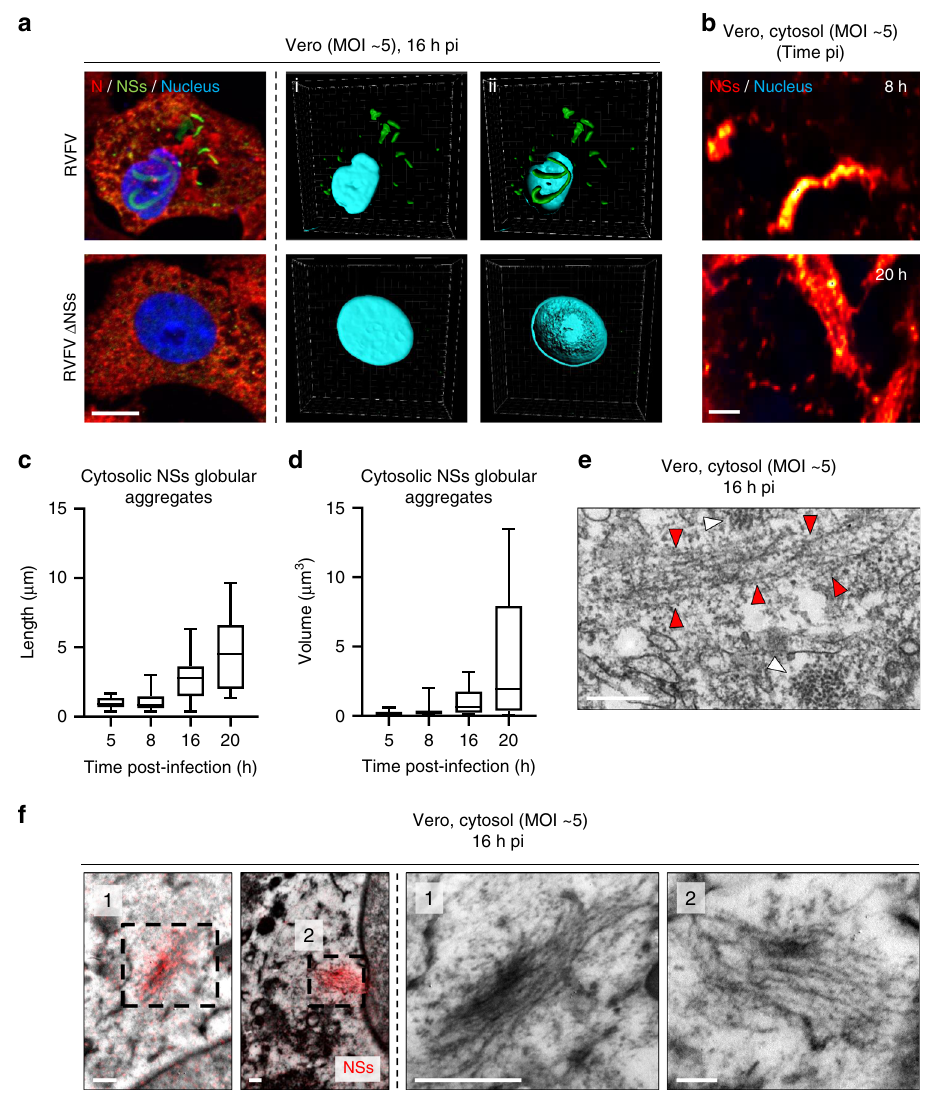
Fig. 6 NSs assembles into short cytosolic amyloid-looking fi brillary aggregates. a Vero cells were infected for 16 h with RVFV or RVFV Δ NSs, both at a MOI of 5. Infected cells were imaged by confocal microscopy after labeling of nuclei with Hoechst (blue) and immuno fl uorescence staining of intracellular RVFV proteins N (red) and NSs (green). The left panel shows Z-stack projections whereas the three others are 3D-reconstructions obtained with IMARIS software and displaying (i) cytosolic NSs and (ii) nuclear NSs. Results are representative of three independent experiments. Scale bar, 10 µ m. b Vero cells were infected with RVFV for 8 and 20 h and subjected to immuno fl uorescence staining against NSs. Cytosolic NSs aggregates (red/yellow) and nuclei (blue) were imaged by STED microscopy. Images are representative of independent experiments. Scale bar, 1 µ m. c , d Vero cells were exposed to RVFV (MOI ~5) for up to 20 h. The length ( c ) and volume ( d ) of cytosolic NSs globular aggregates was measured as described in Fig. 1h. n = 13, 41, 21, and 11 cytosolic NSs globular aggregates were examined at 5, 8, 16, and 20 h pi, respectively. Center line, median; box limits, upper and lower quartiles; whiskers, min. to max. range. e Vero cells were exposed to RVFV and imaged by TEM 16 h later. White and red arrowheads indicate cross- and longitudinal-sections of fi brils in the cytosol, respectively. Images are representative of three independent experiments. Scale bar, 200 nm. f Cytosolic aggregates imaged by CLEM following immuno fl uorescence staining against NSs (red). Fiber-arrays overlaid with the red fl uorescence channel. Higher magni fi cations of cytosolic aggregates consisting of thin, short NSs fi brils are shown (black numbers and dashed squares). Experiments were repeated independently thrice with similar results. Scale bars, 250